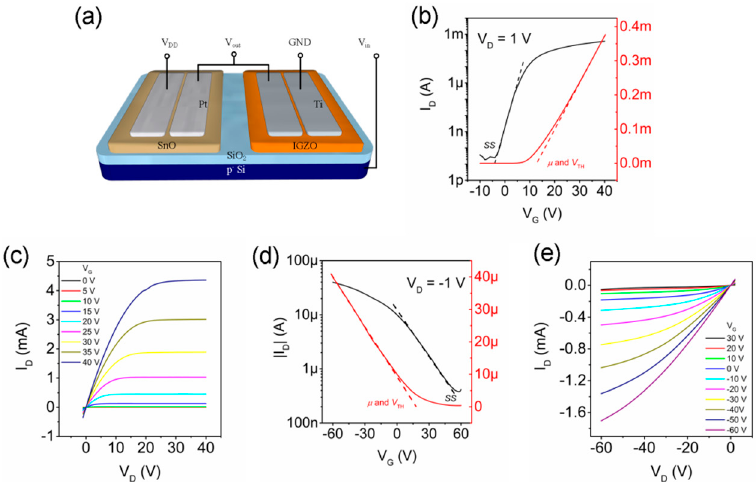
Figure 1. ( a ) Schematic of the SnO and IGZO TFTs; ( b ) Transfer and ( c ) output characteristics of the IGZO TFT; ( d ) Transfer and ( e ) output characteristics of the SnO TFT.